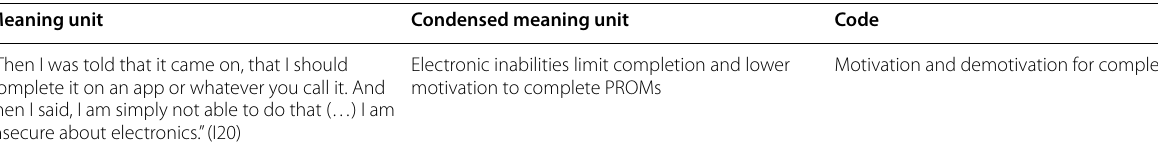
Table 2 Example of the analytic process Meaning unit Condensed meaning unit